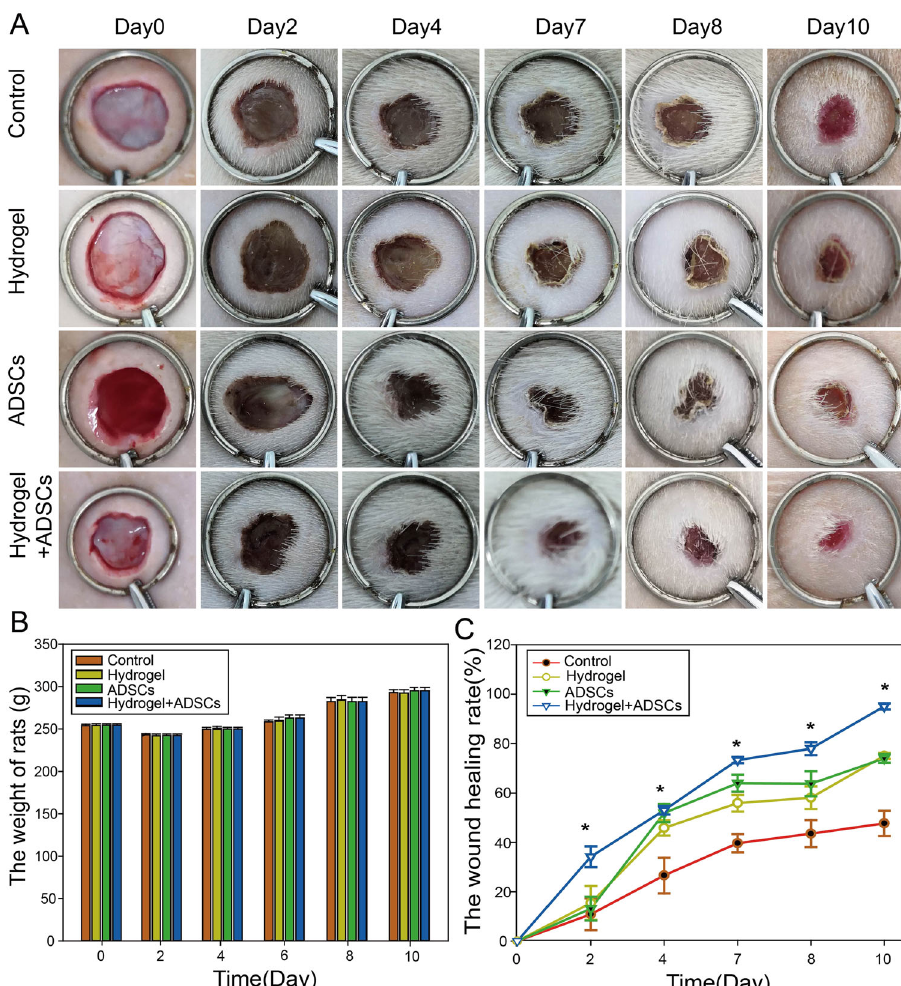
Fig. 3 ADSCs-loaded β -ChNF hydrogel increased the wound healing rate in rats. A Photographs of wounds closure from 0 to 10 d after surgery. B Weight shown no changes during the treatment period. C The wound healing rate of full-thickness wounds for each treatment group. * P < 0.05, vs. the control